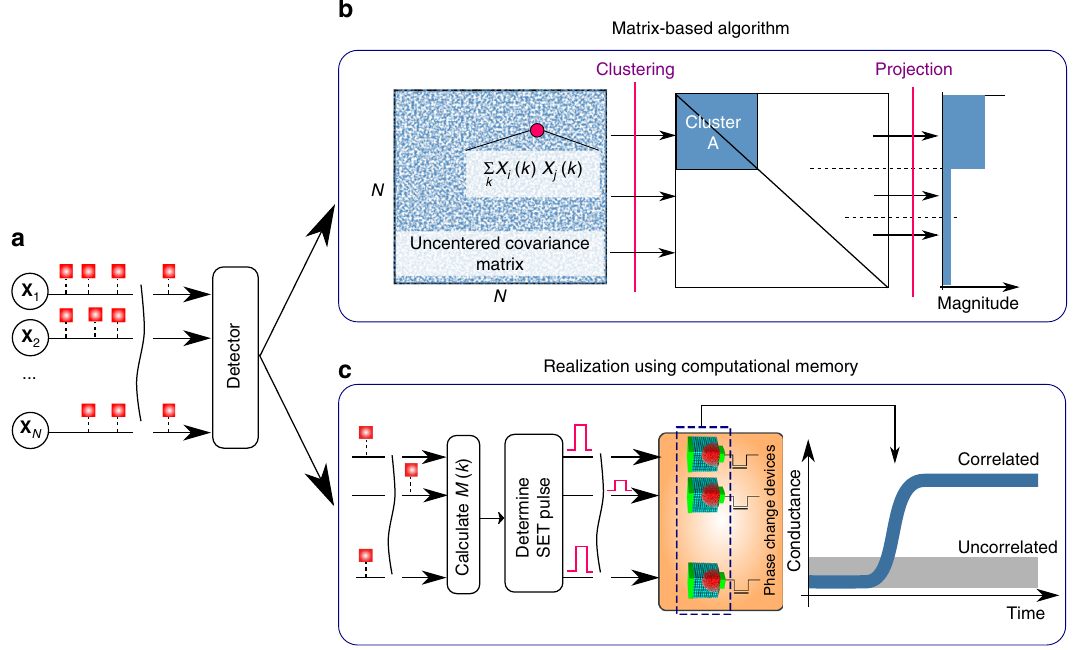
Fig. 3 Temporal correlation detection. a Schematic of N stochastic binary processes, some correlated and the remainder uncorrelated, arriving at a correlation detector. b One approach to detect the correlated group is to obtain an uncentered covariance matrix. By summing the elements of this matrix along a row or column, we can obtain some kind of numerical weights corresponding to the N processes and can differentiate the correlated from the uncorrelated group based on their magnitudes. c Alternatively, the correlation detection problem can be realized using computational memory. Here each process is assigned to a single phase change memory device. Whenever the process takes the value 1, a SET pulse is applied to the PCM device. The amplitude or the width of the SET pulse is chosen to be proportional to the instantaneous sum of all processes. By monitoring the conductance of the memory devices, we can determine the correlated